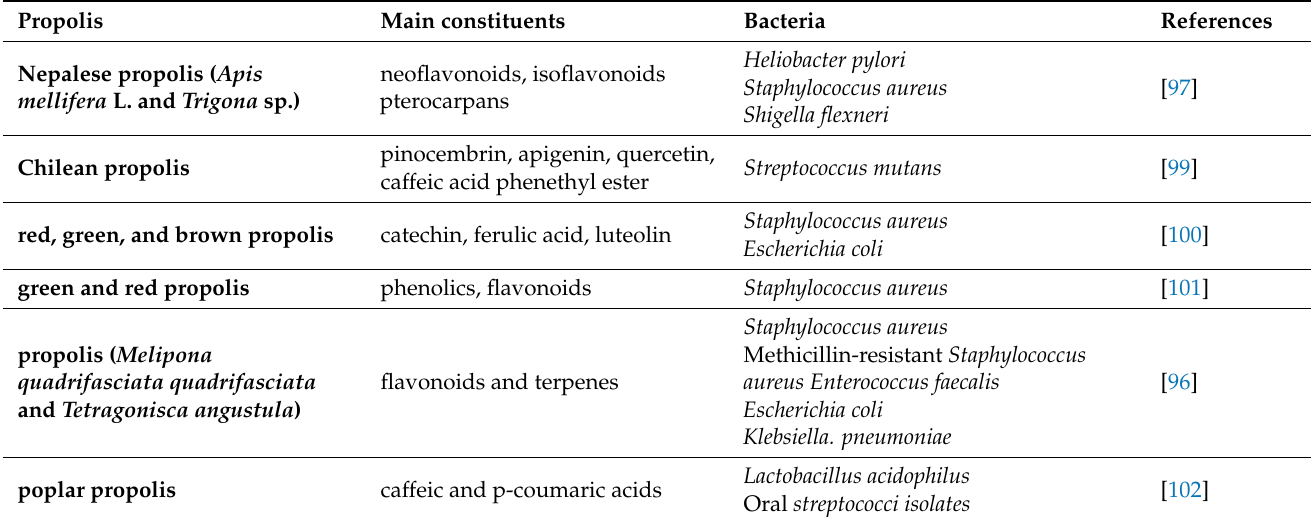
Table 6. The antibacterial activity of various propolis with their main